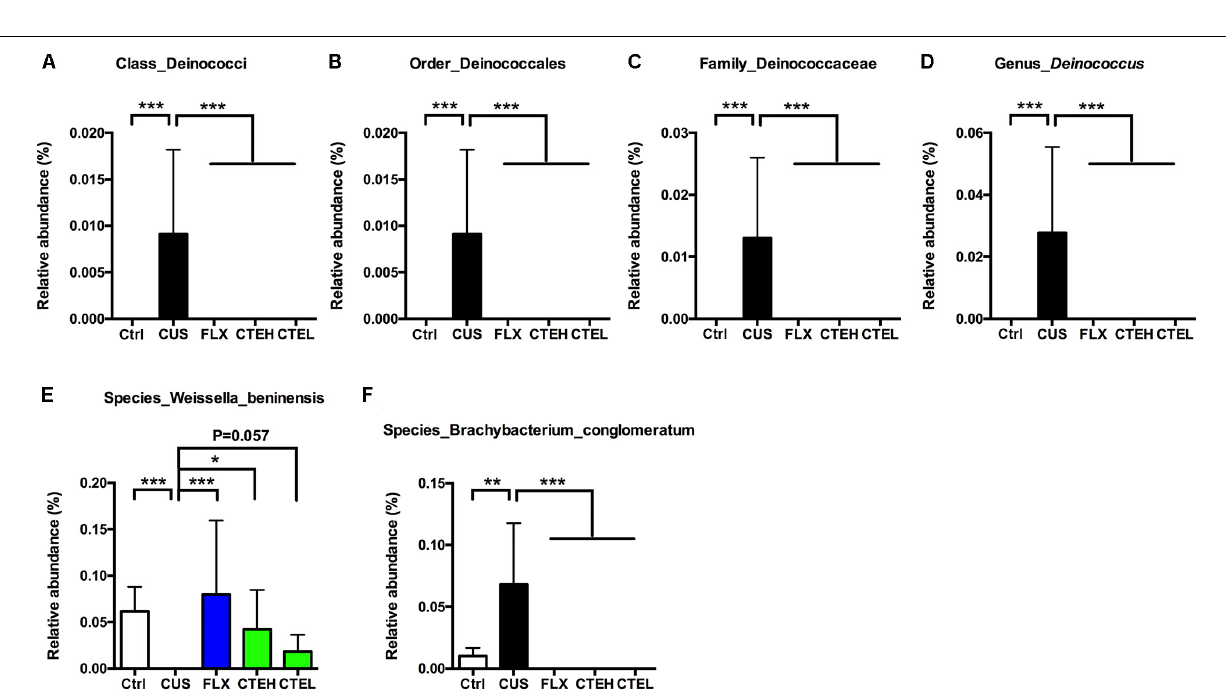
FIGURE 5 | Relative abundance of Deinococcus in different taxonomic levels: (A) class level, (B) order level, (C) family level, (D) genus level. Relative abundance of selected species with significant differences among each group. Relative abundance of Weissella beninensis (E) , and Brachybacterium conglomeratum (F) . Ctrl, control; CUS, chronic unpredictable stress; FLX, fluoxetine; CTEH, C. tubulosa extract high dose; CTEL, C. tubulosa extract low dose. ∗ P < 0.05, ∗∗ P < 0.01, ∗∗∗ P < 0.001 ( n = 8, mean ±